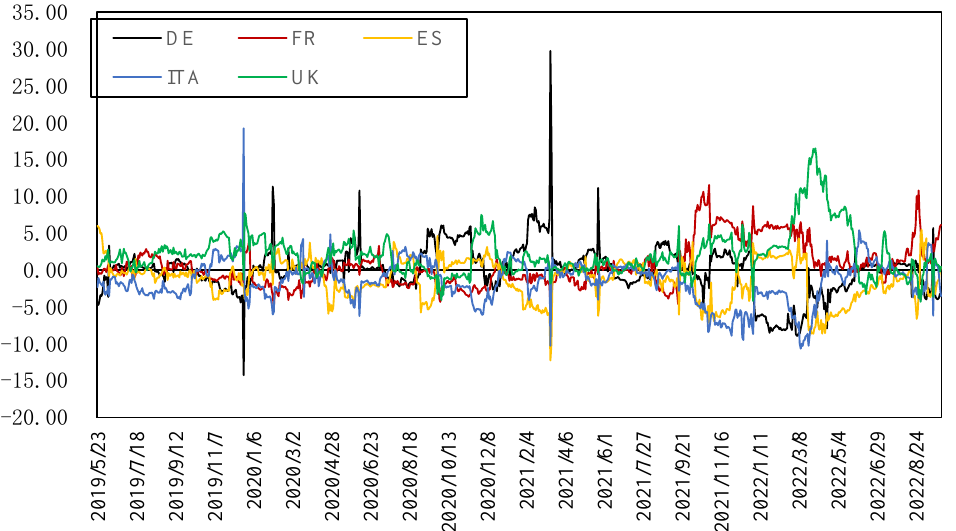
Figure 6. Net spillover indexes of five electricity returns.